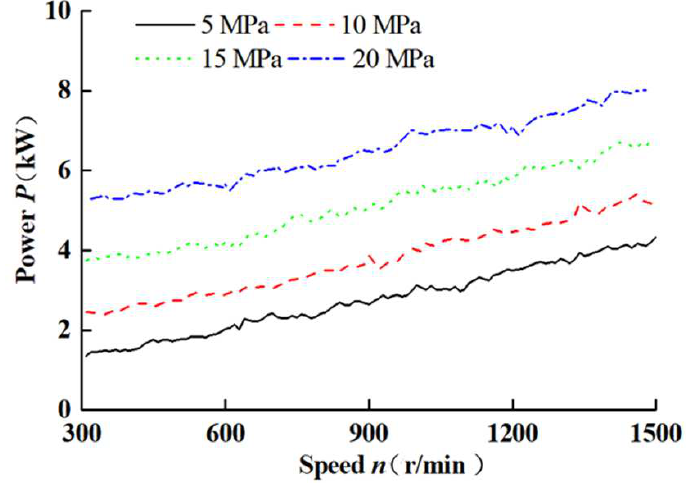
Figure 16. Motor output power under pressure-maintaining status.